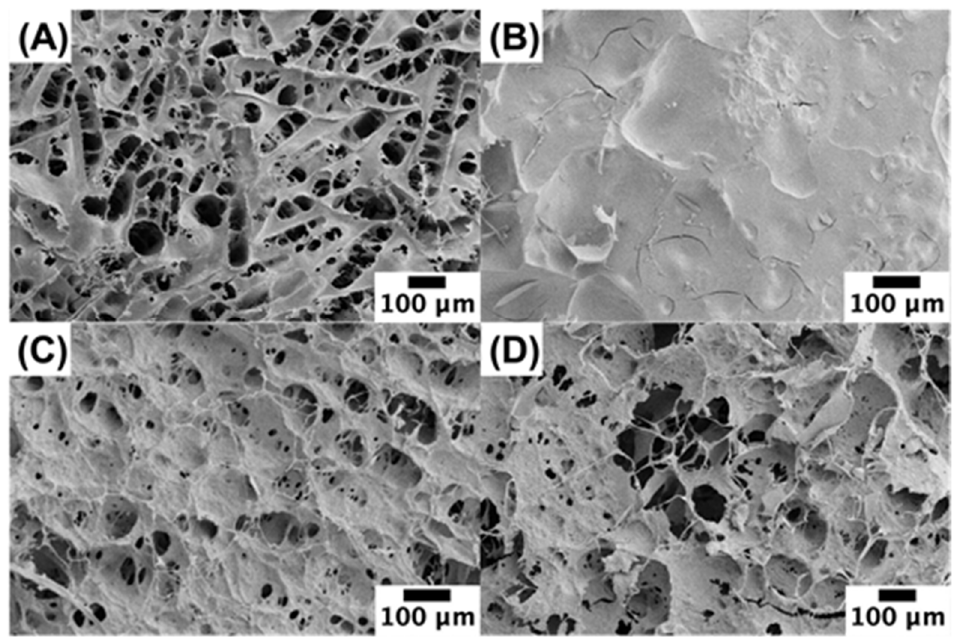
Figure 6. Scanning electron microscopy images of scallop ( A ) and scallop analogs containing 0% ( B ), 0.5% ( C ) and 1.0% ( D ) pectin. All scallop analogs contained 10% pea protein and 2% transglutami- nase.